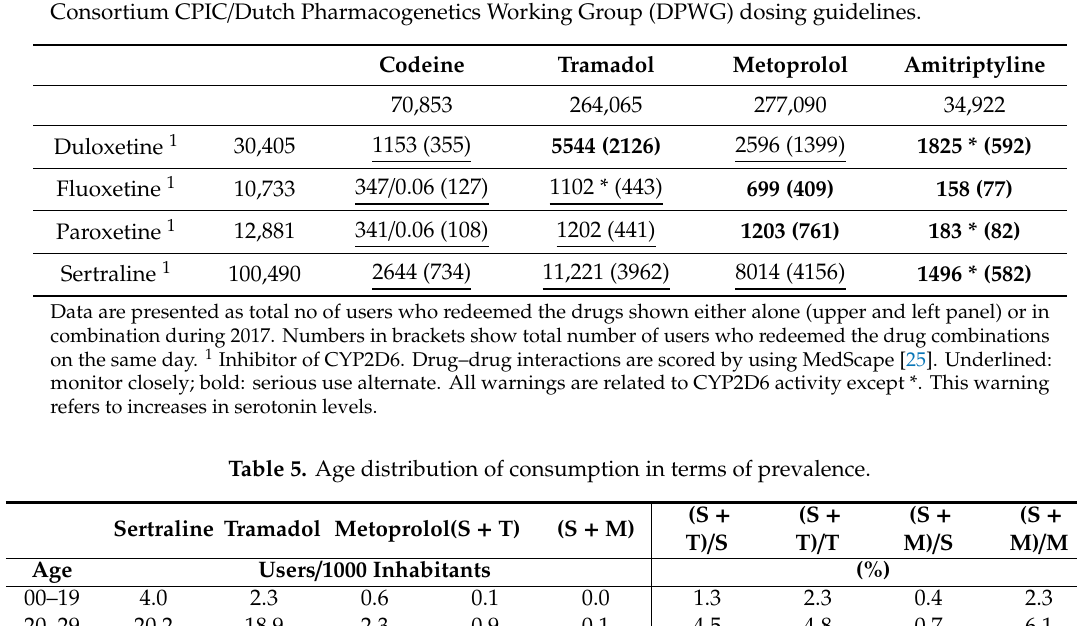
Table 4. Consumption of drug combinations having Clinical Pharmacogenetics Implementation